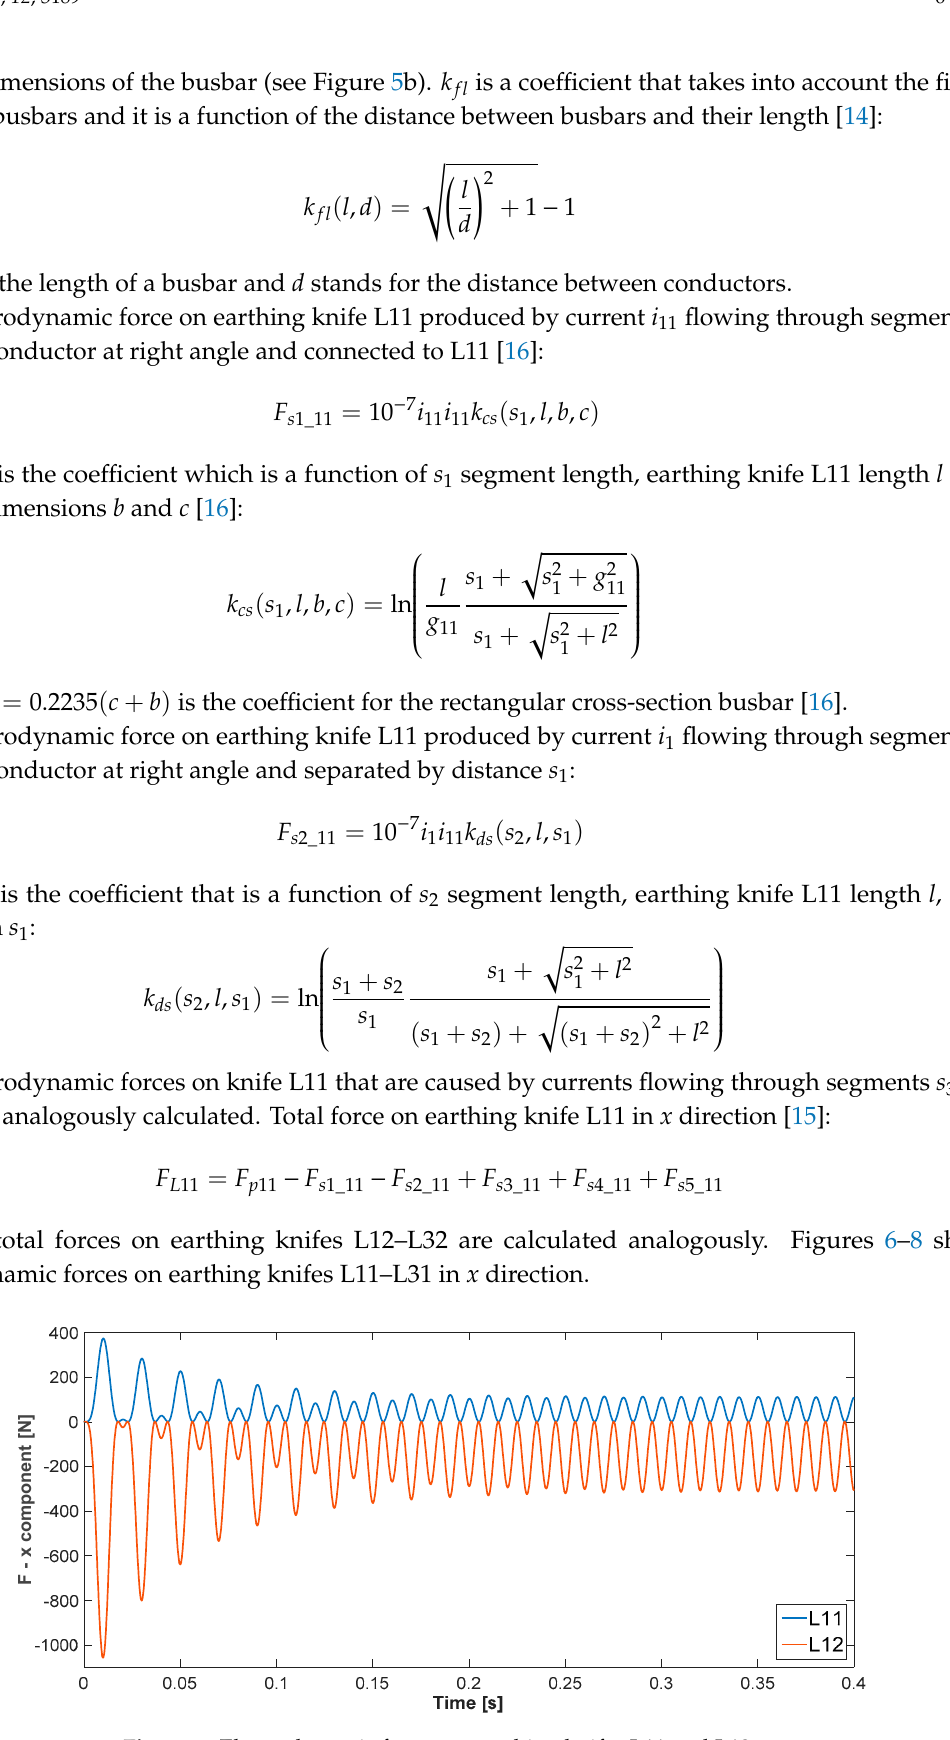
Figure 6. Electrodynamic forces on earthing knifes L11 and L12.